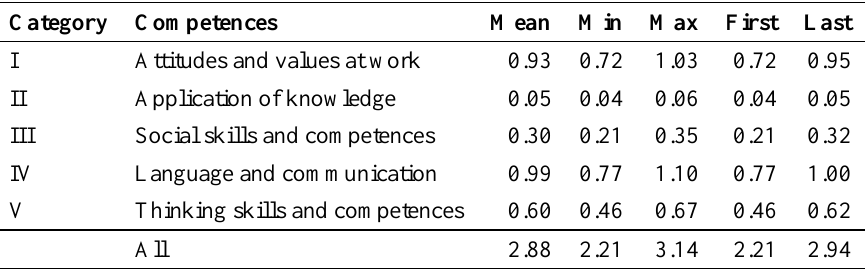
Table 1 : Number of transversal competences per job offer in Poland, November 2012–December 2015 Category Competences Mean Min Max First Last I Attitudes and values at work 0.93 0.72 1.03 0.72 0.95 II Application of knowledge 0.05 0.04 0.06 0.04 0.05 III Social skills and competences 0.30 0.21 IV Language and communication 0.99 0.77 V Thinking skills and competences 0.60